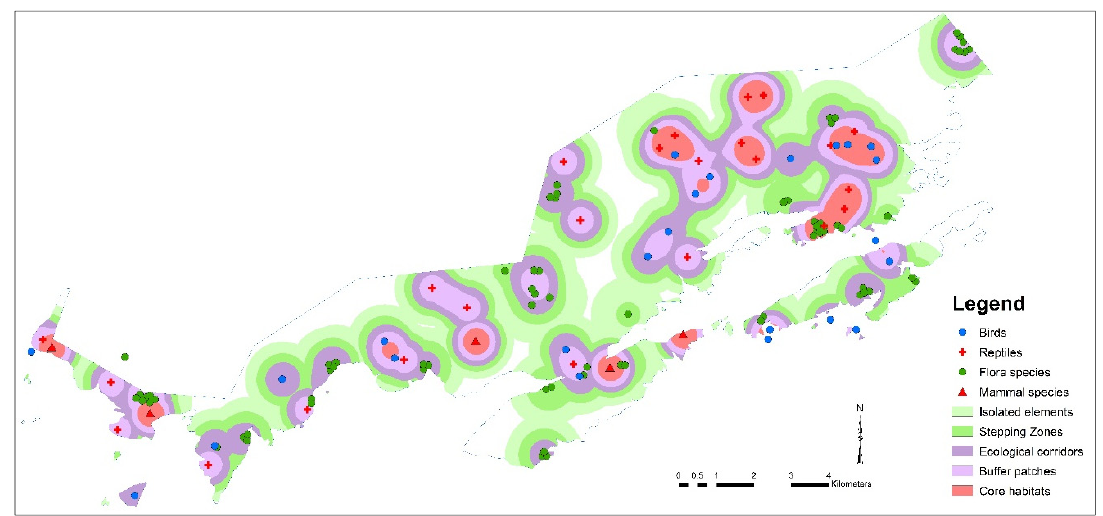
Figure 12. Habitat network map produced by integrating the results in Figure 11 according to the maximum class value of each grid point. The flora and fauna locations are shown on the map.